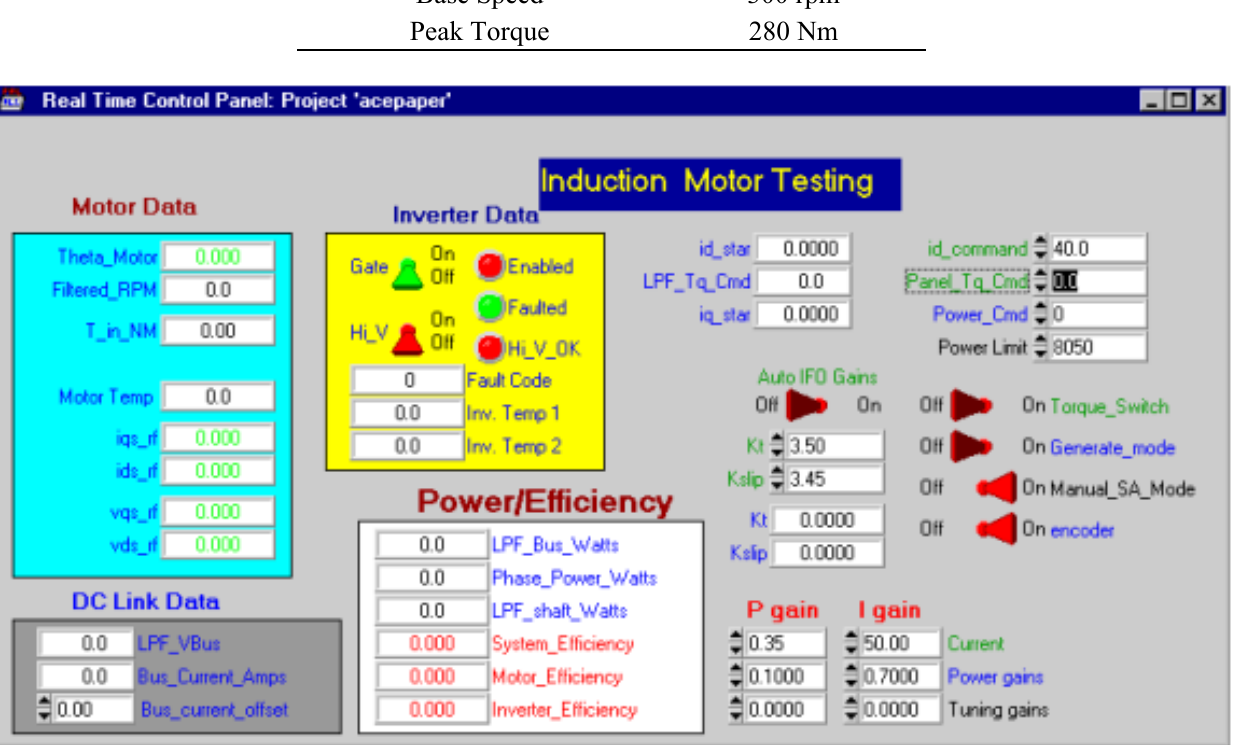
Figure 5. Control panel for induction motor